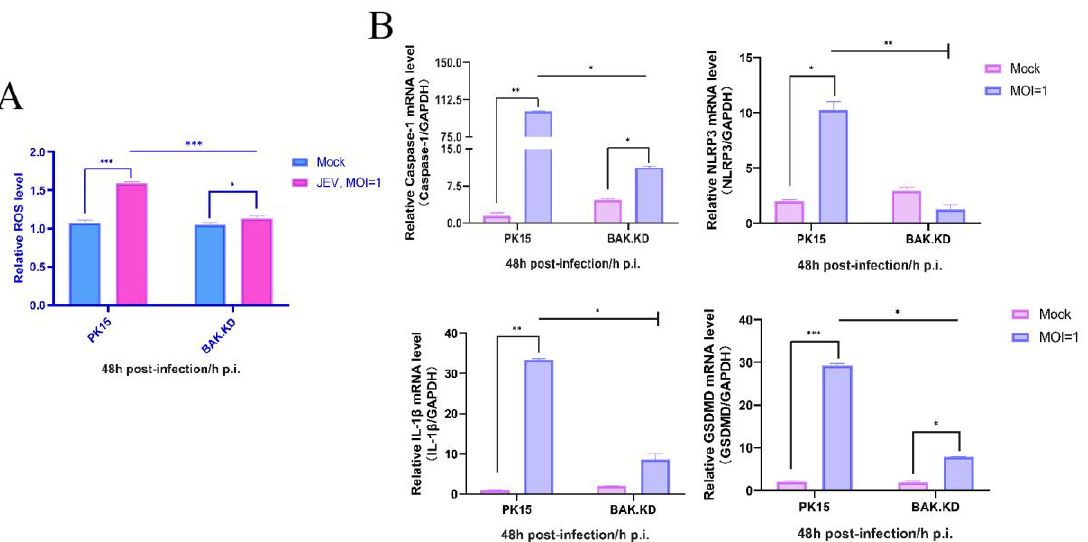
Figure 3. Knockdown of BAK function inhibits JEV-activated ROS and other cytokines. ( A ) DCFH- DA probes were loaded into normal and knockdown cells infected with JEV (MOI = 1, 48 hpi, experimental group) and controls. Fluorescence signals were collected at an excitation wavelength of 488 nm and emission wavelength of 525 nm, relative levels of intracellular ROS were calculated, and data were normalized and displayed as fold change (the data of the control group and the experimental group were normalized at the same time). ( B ) The relative mRNA levels of Caspase-1, NLRP3, IL-1β, and GSDMD in BAK.KD after JEV infection (MOI = 1, 48 hpi) were detected by real-time quantitative RT-PCR, and PK-15 cells were used as the control. * ( p < 0.05), ** ( p < 0.01), *** ( p < 0.001), and ns (not significant).